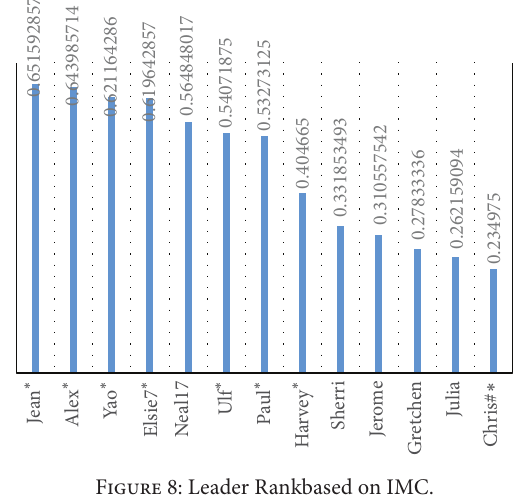
Figure 8: Leader Rankbased on IMC.